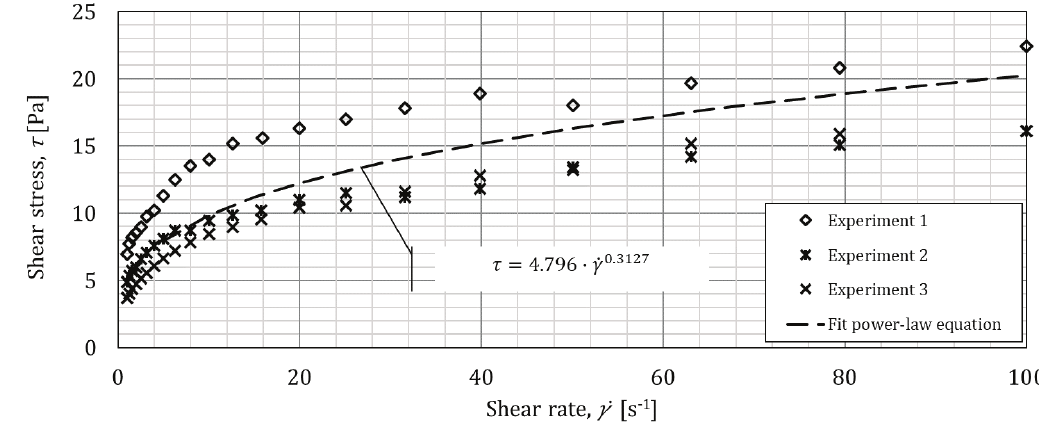
Fig. 1 – Measured and fit rheology curves of the gel